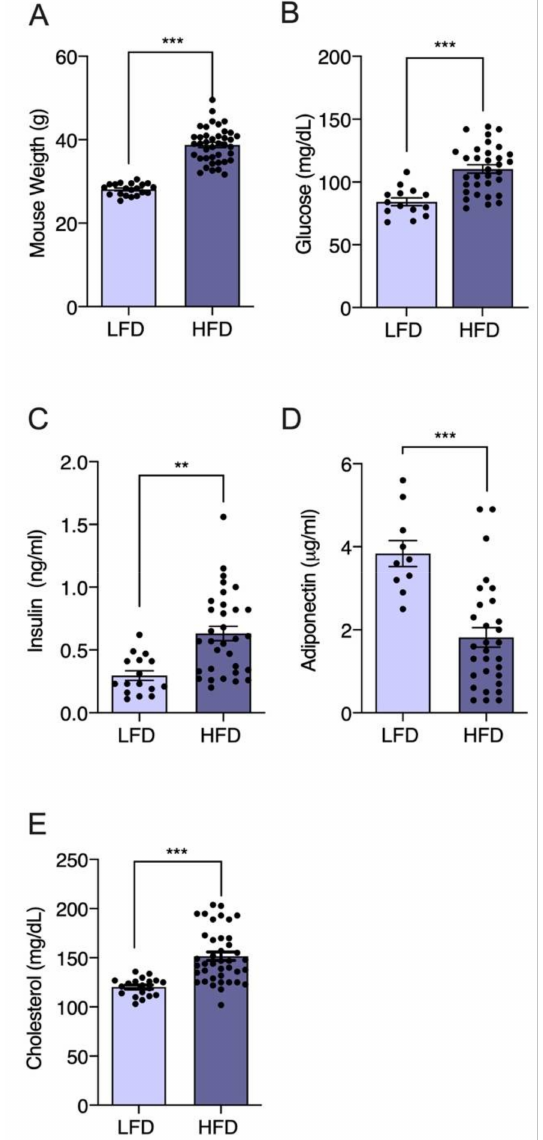
Figure 3. Promotion of weight gain and glucose and insulin resistance in male C57BL/6J mice administered a high-fat diet (HFD). Six-week-old mice were treated for an additional 6 weeks with a low-fat diet (LFD, n = 20) and HFD ( n = 40). The ( A ) weight recording in groups of mice given LFD and HFD after 6 weeks of treatment. During the whole period, weights were recorded twice a week. Values are expressed as mean recorded weight ± SEM, *** p < 0.001 (unpaired t -test). The ( B – E ) biochemical blood parameters were measured in both groups: plasma glucose (mg/dL), plasma insulin (ng/mL), plasma adiponectin ( µ g/mL), and plasma cholesterol (mg/dL). Values are expressed as mean ± SEM, and significant differences are highlighted between LFD and HFD groups. ** p < 0.01 and *** p < 0.001 (unpaired t